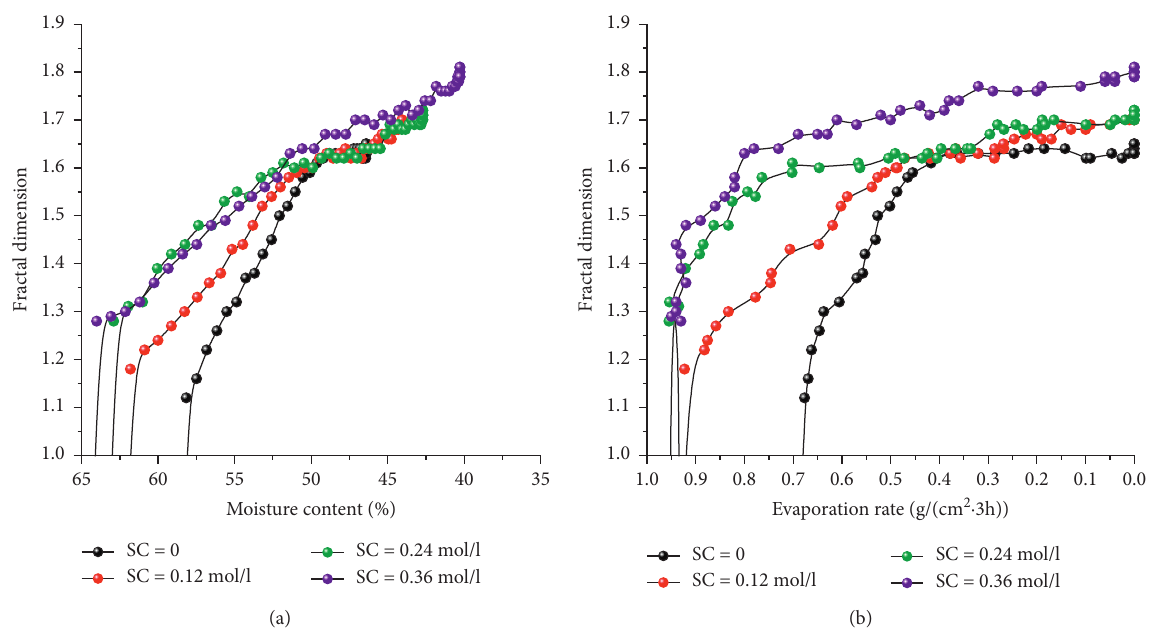
Figure 5: Fractal dimension varying with moisture content and evaporation rate under different saline concentrations. (a) Fractal di- mension varying with moisture content. (b) Fractal dimension varying with evaporation rate.